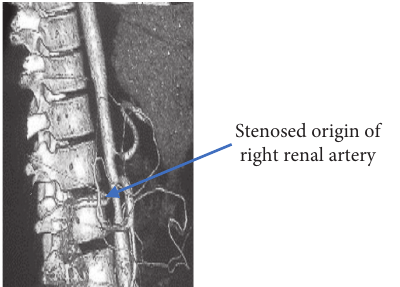
Figure 2: CTA showing the stenosed origin of the right renal artery.